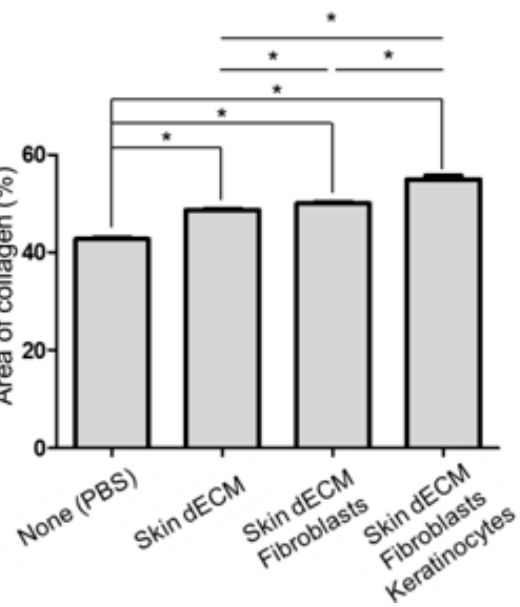
Figure 7. Quantification of area of collagen layer (%) in the histological analysis. Data are presented as the mean ± standard error of mean ( n = 3 per groups) and analyzed using a Student’s t-test (* p < 0.05).